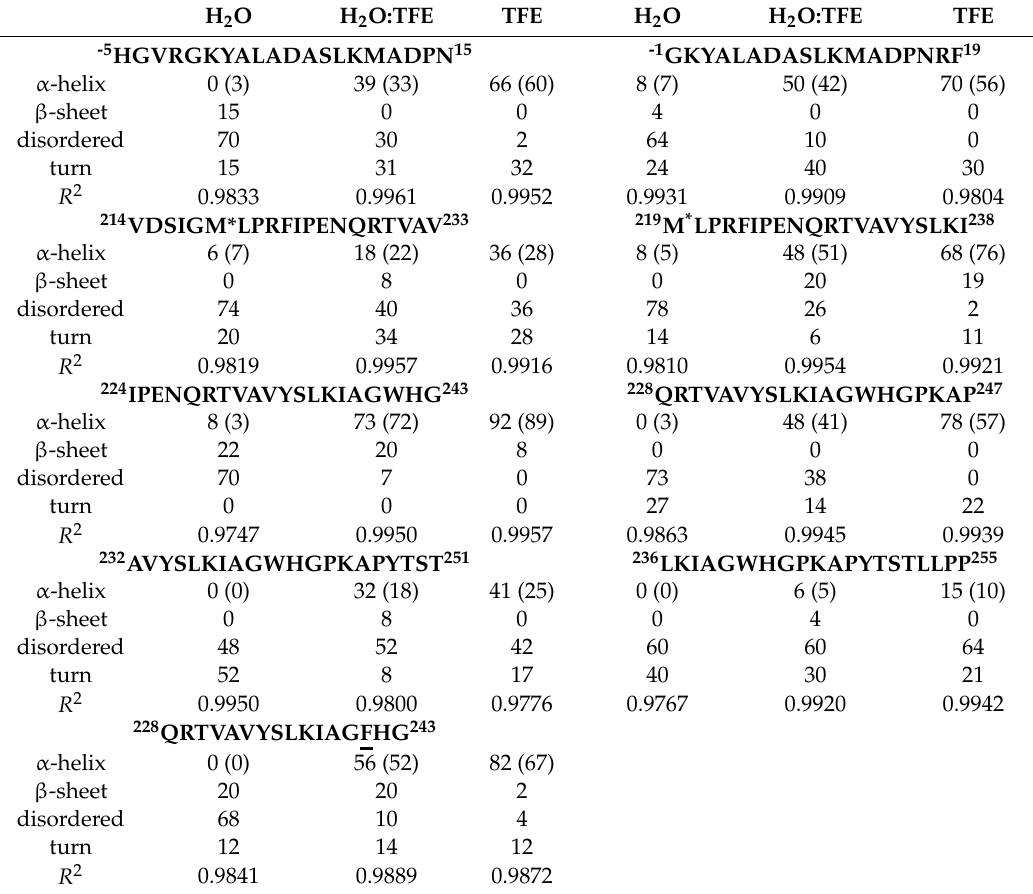
Table 2. Estimation of the secondary structure fraction of acetylated HSV peptides. Far-UV CD spectroscopic data were analysed by using the MS Excel version of the PEPFIT program. Values in bracket show the helical content obtained with the formula of Chen and Yang [32]. M*: methionine residue has been substituted by